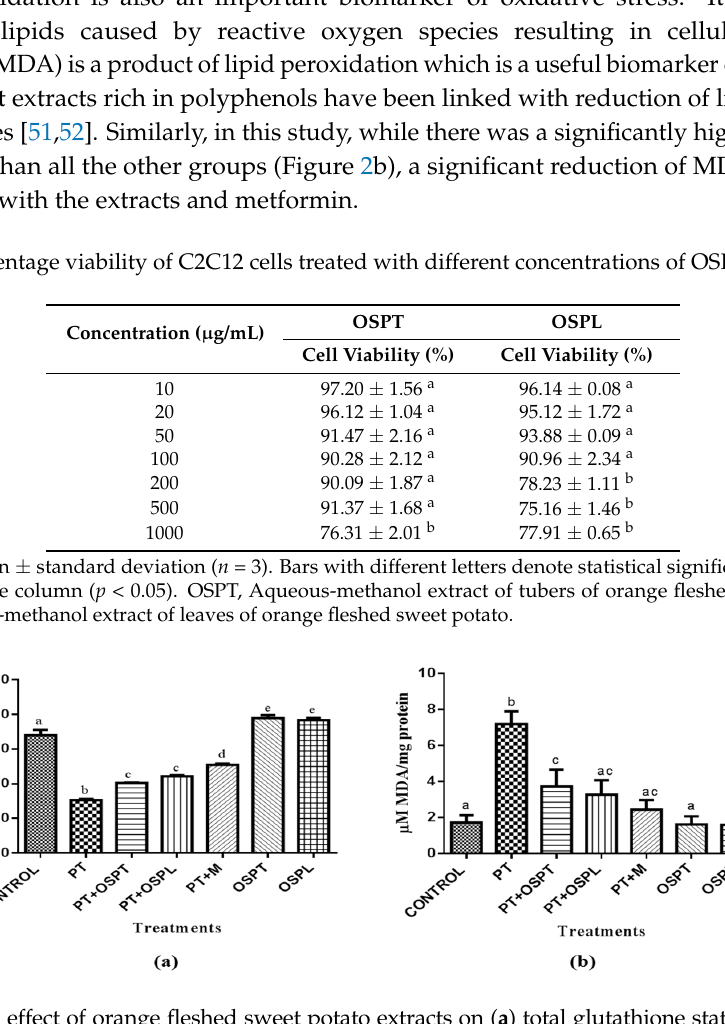
Figure 2. The effect of orange fleshed sweet potato extracts on ( a ) total glutathione status (GSH) and ( b ) lipid peroxidation in treated C2C12 myotubes. Treatment groups were palmitate (PT), palmitate and tubers’ extract of orange fleshed sweet potato (PT + OSPT), palmitate and leaves’ extract of orange fleshed sweet potato (PT + OSPL), palmitate and metformin (PT + M), tubers’ extract of orange fleshed sweet potato only (OSPT), leaves’ extract of orange fleshed sweet potato only (OSPL). Different letters denote statistical significant differences between results ( p < 0.05), Bars indicate standard deviation ( n = 3).